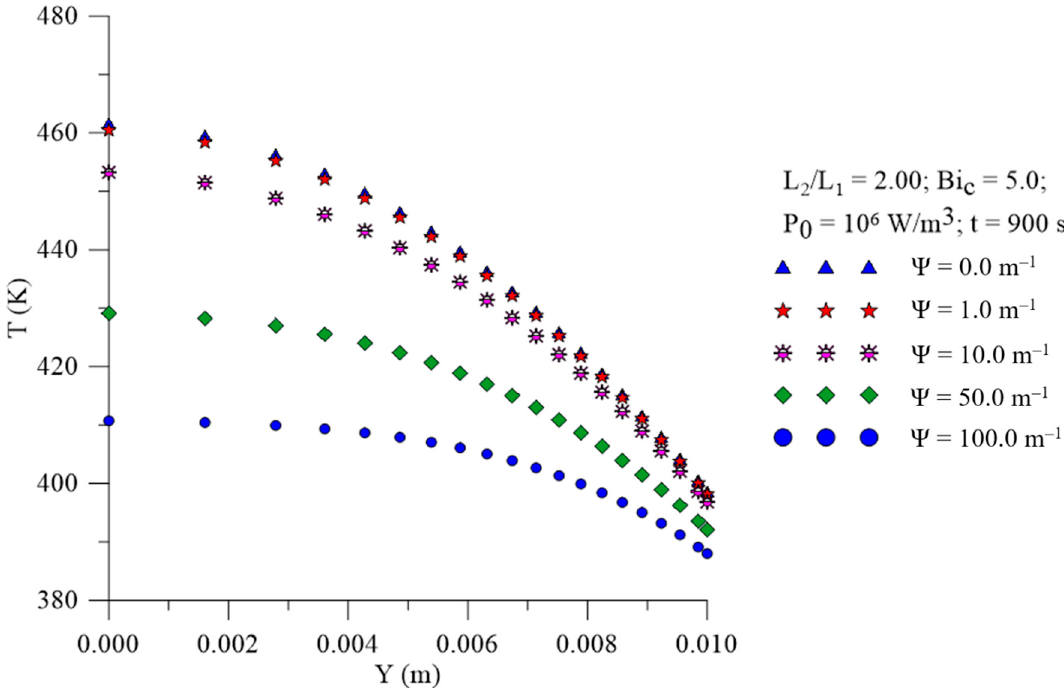
Figure 16. Temperature inside a prolate spheroidal solid with aspect ratio L 2 /L 1 = 2.0, different attenuation factors and fixed microwave power density and heat transfer Biot number ( y -axis, z = 0, t = 900 s).